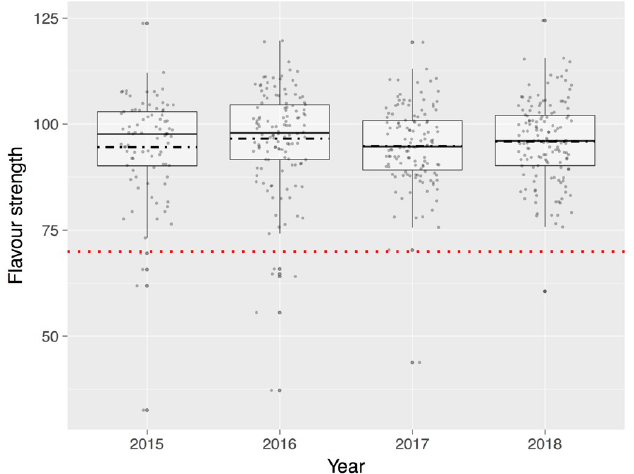
Fig. 6: Boxplots of coloring strength (crocin) of the saffron samples col- lected/analyzed during the four years (2015-2018). Red broken line shows the minimum limit of the first quality category (ISO 3632 1,2:2010-2011). For each boxplot, mean (black broken line) and me- dian (black line) were highlighted.